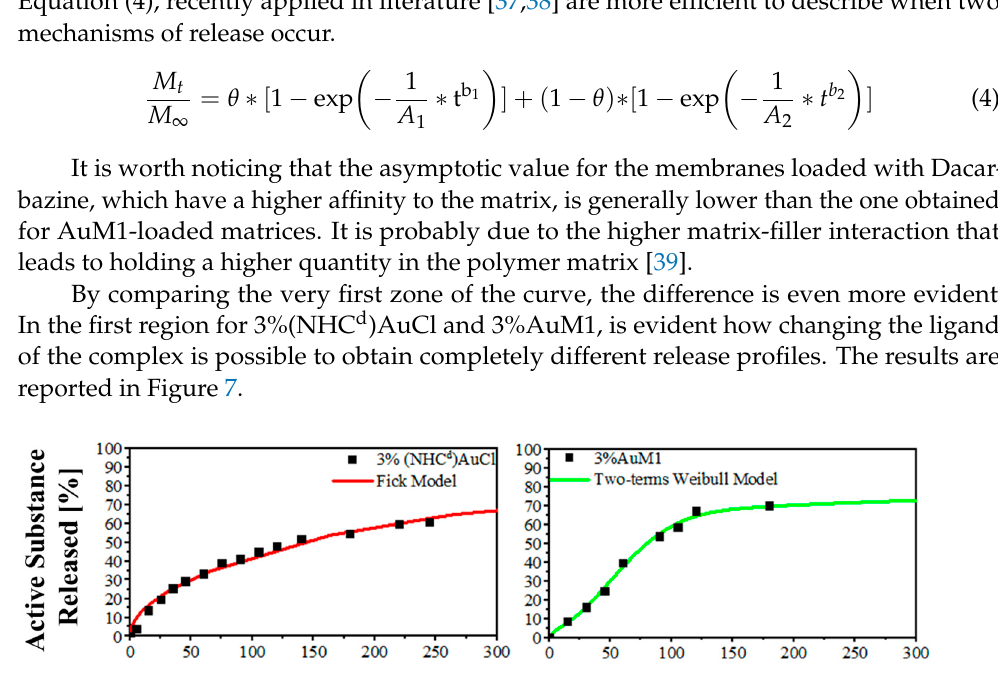
Table 3. Two-terms Weibull parameters for electrospun systems.